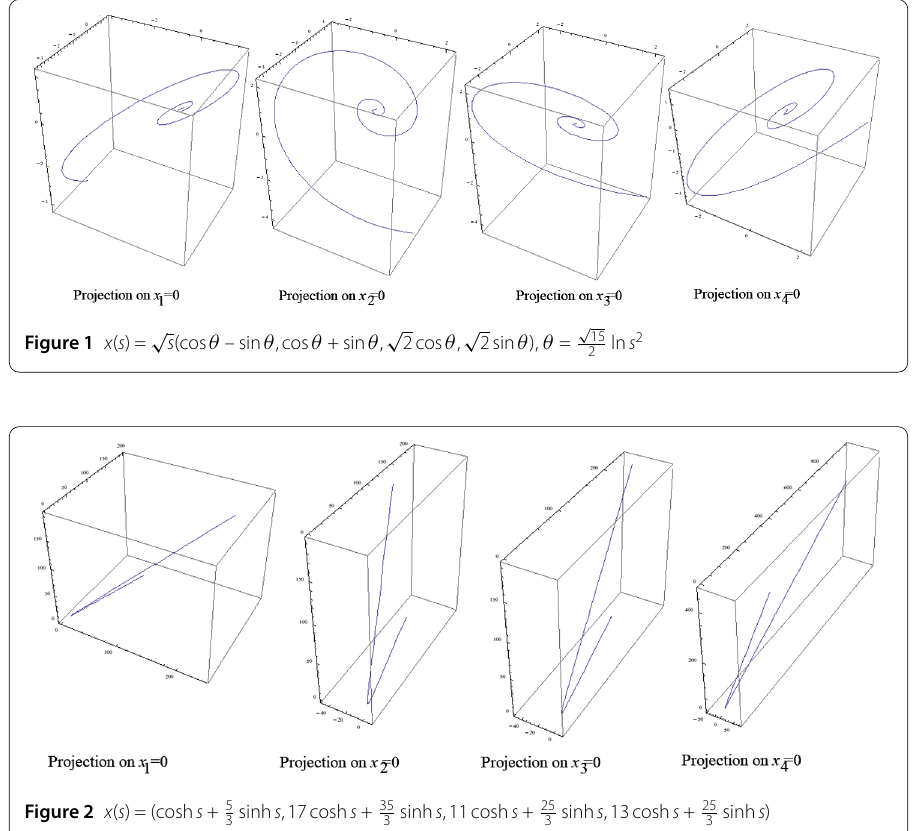
sinh s ,13cosh s + 25 3